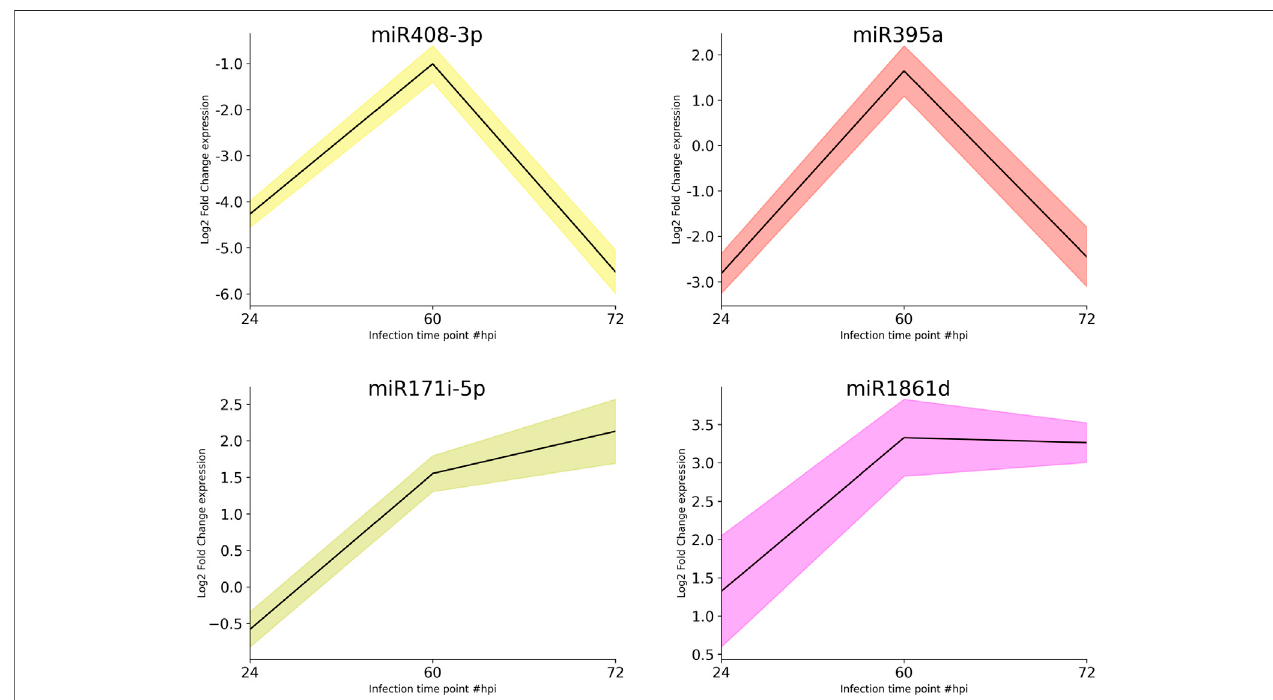
FIGURE 5 | qRT-PCR. The total RNA was isolated from the control and R. solani -infected plants at various time points. Initially, RT-PCR was performed to assure the miRNA primer quality and speci fi c ampli fi cation. After ensuring the primer quality, qRT-PCR was performed to quantify miR395a, miR408-3p, miR171i-5p, and miR 1861d.ThebarplotsrepresenttheapproximatedifferentialexpressionlevelsofthecandidatemiRNAsgeneratedbytheqRT-PCRtechnique.Thedifferentialexpression levelsweredeterminedinfolddifferenceusingthe2 − ΔΔ CT methodforthe R.solani -infectedriceplantatvarioustimepoints,namely,24,60,and72 hpi,withrespect to the uninfected plant grown under controlled conditions.